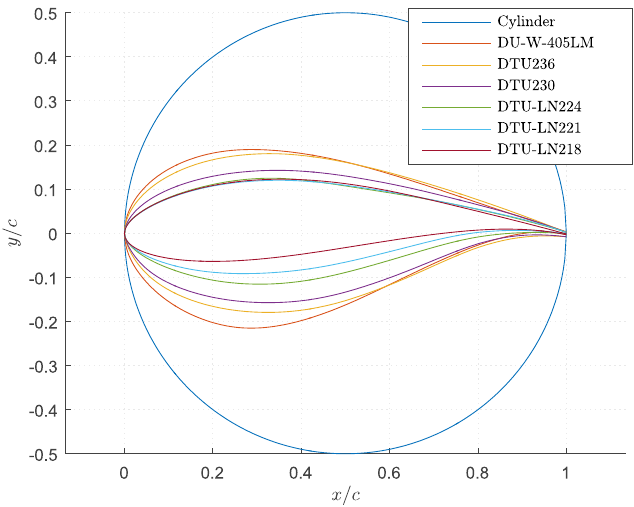
Figure 3. Airfoil profiles used for the blade design consisting of the DTU series, DU-W-405LM, and a cylinder.